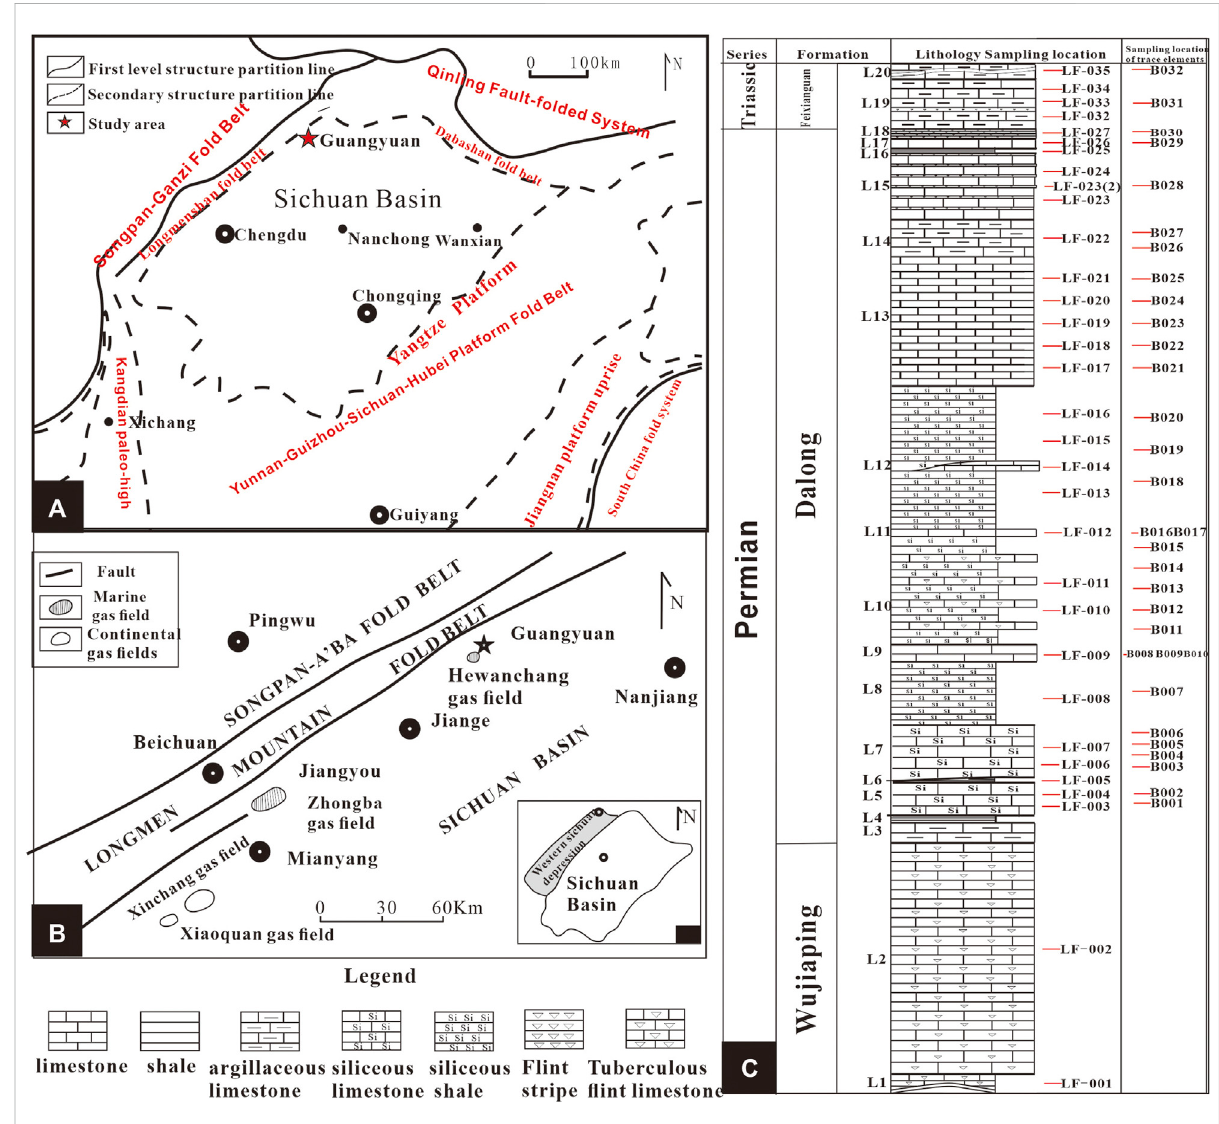
FIGURE 1 Geographical map of Sichuan Basin and sampling location (A) Geographical map of the Sichuan Basin. (B) Distribution of gas fi elds in the Sichuan Basin. (C) Lithological column of the Dalong Formation in Guangyuan and this study ’ s sampling